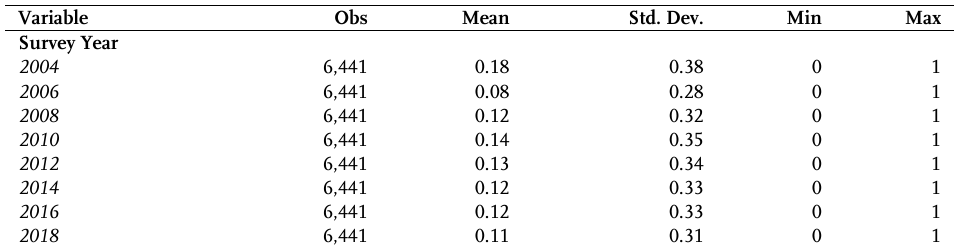
Table A.1 : Descriptive female immigrants, model sample (continued) Variable